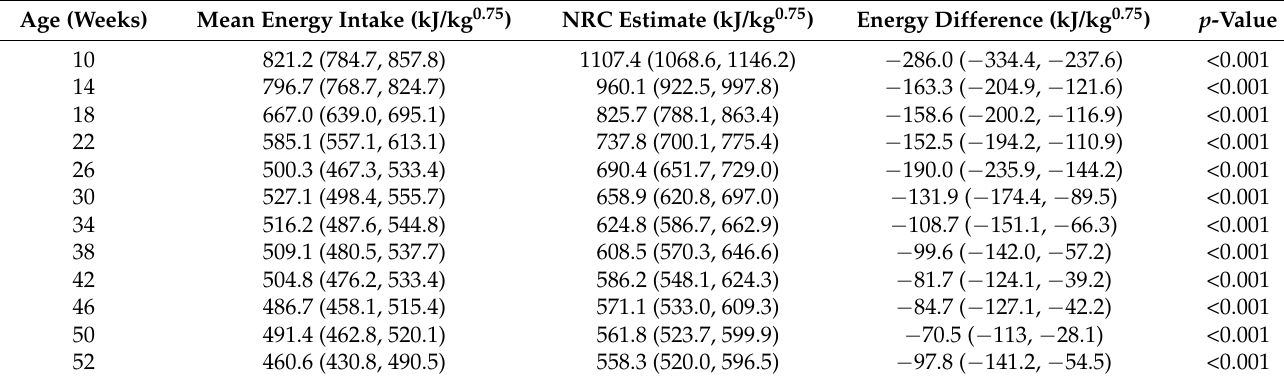
Figure 4. The energy intake of seventeen Norfolk Terriers ( ● ) in comparison with the energy requirements predicted by the National Research Council (2006) equation ( ◦ ). Data are means, with 95 % confidence intervals represented by vertical bars. * Significant difference ( p < 0·05). Table 1. The monthly mean energy intake, NRC estimate and energy difference between the two measures, from seventeen Norfolk Terriers, are shown in the table below. Energy intakes are displayed as kJ/kg 0·75 with 95% confidence intervals in brackets.